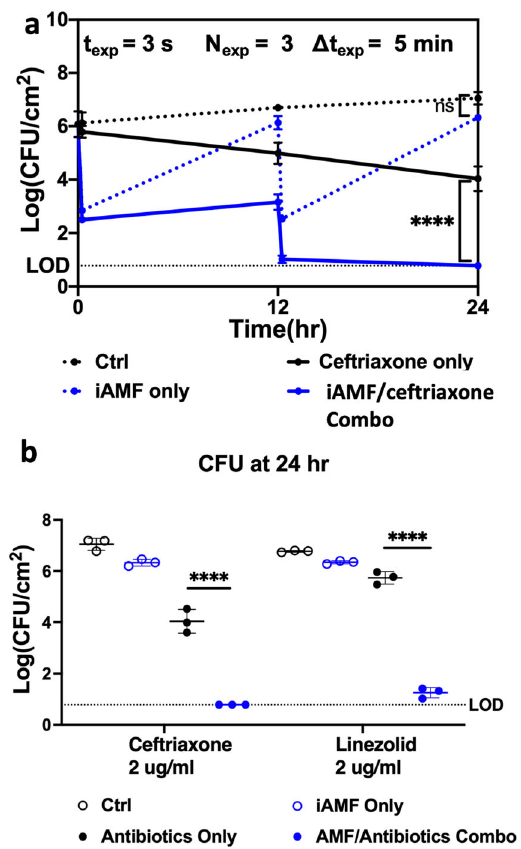
Fig. 5 iAMF and antibiotics are synergistic in reducing S. aureus bio fi lm. S. aureus (UAMS1) bio fi lm was treated with iAMF doses at 0 and 12 h ( T max = 65 °C, Δ t exp = 5 min, 15 min per dose) and speci fi ed antibiotic. a Bio fi lm log reduction (CFU) post 24 h with iAMF